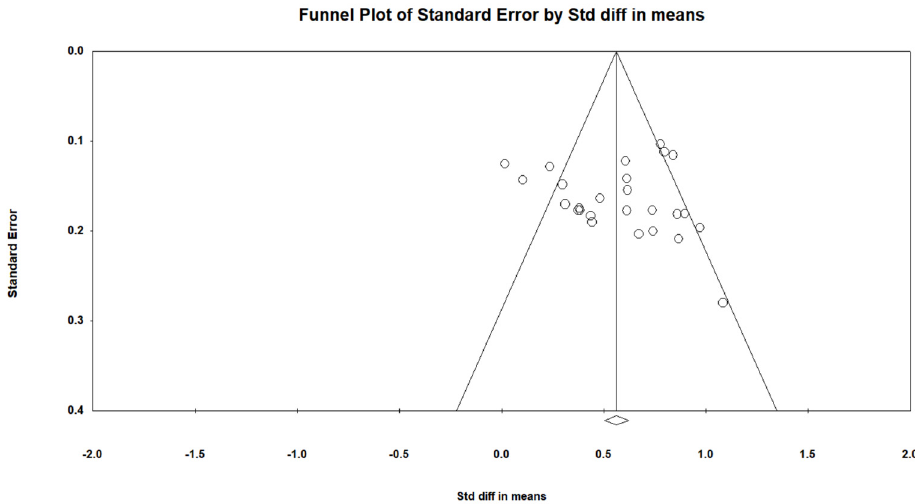
Figure 5. Funnel plot for CVLT-II.